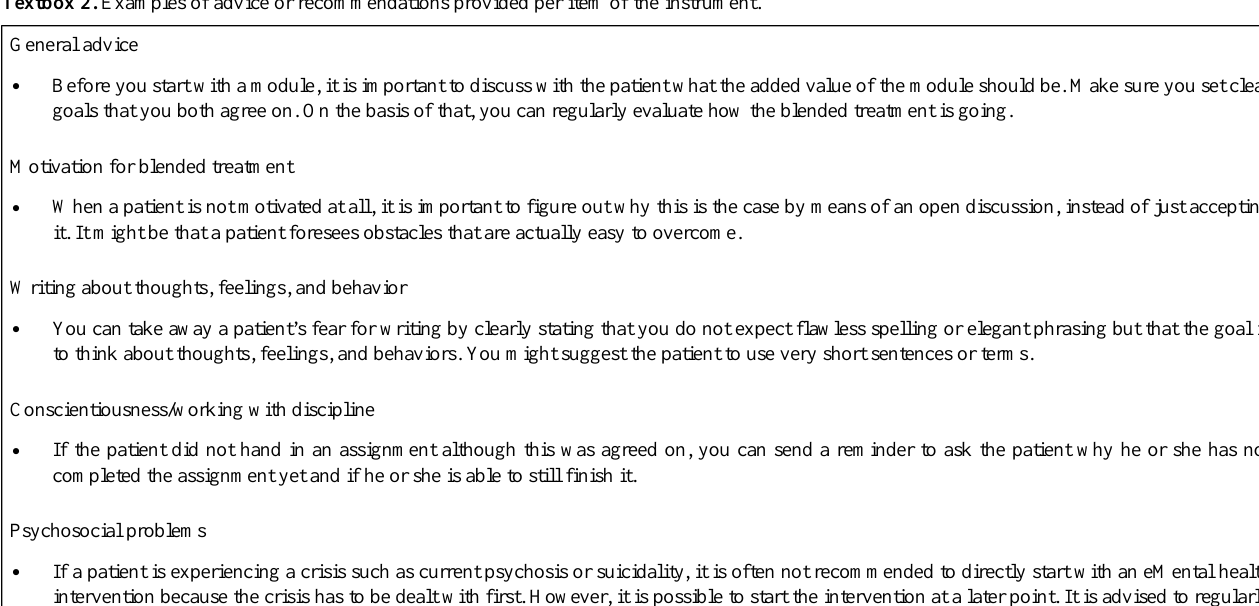
Textbox 2. Examples of advice or recommendations provided per item of the